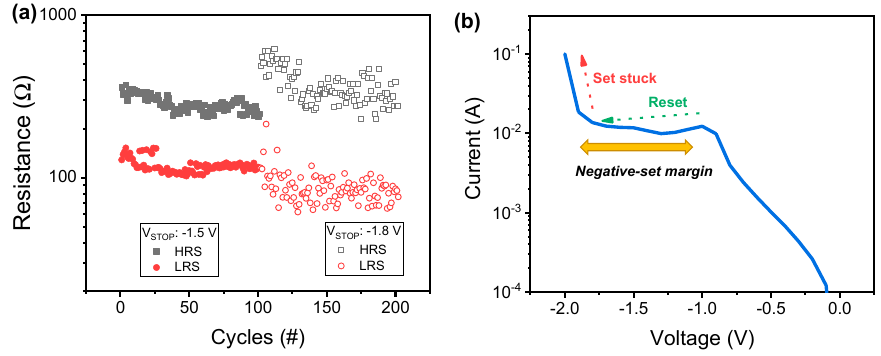
Figure 3. ( a ) DC endurance of the TiN/WO x /Pt device according to reset stop voltage. ( b ) Reset switching failure by large voltage sweep.